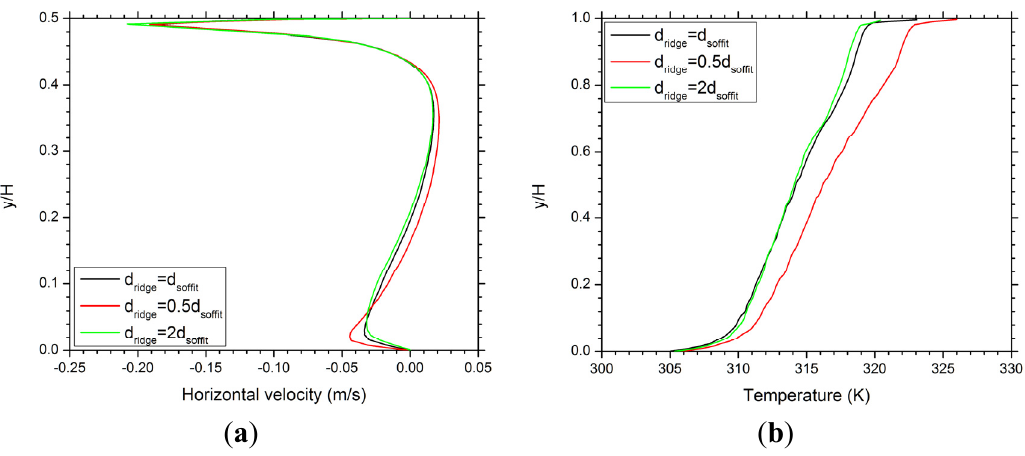
Figure 6. Comparsion of predicted profiles of ( a ) horizontal velocity along the vertical line x = 2 m; and ( b ) temperature along the symmetric line x = 0 between balanced attic ventilation case and two cases of unbalanced attic ventilation at ventilation ratio